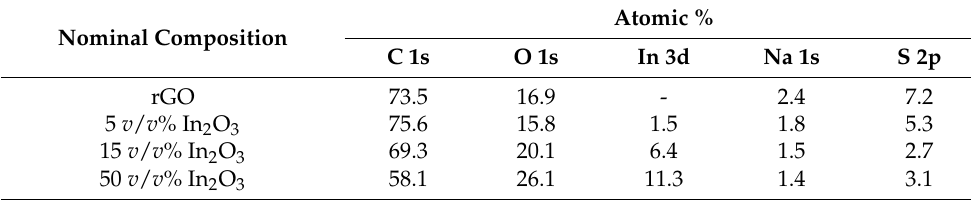
Table 1. Analysis of the chemical surface states of the elements.